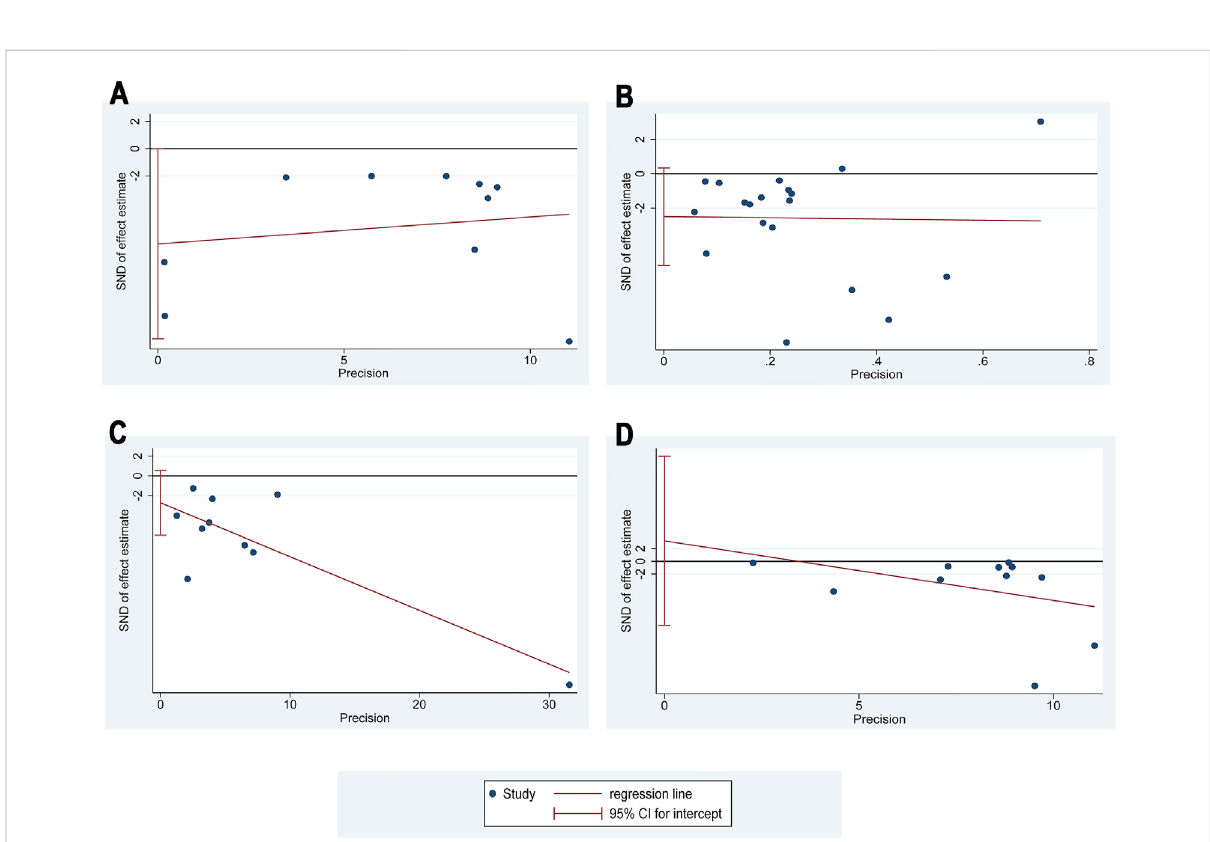
FIGURE 12 Egger ’ s publication funnel plot. (A) Egger ’ s funnel plot of 24hUpro. (B) Egger ’ s funnel plot of Scr. (C) Egger ’ s funnel plot of BUN. (D) Egger ’ s funnel plot of